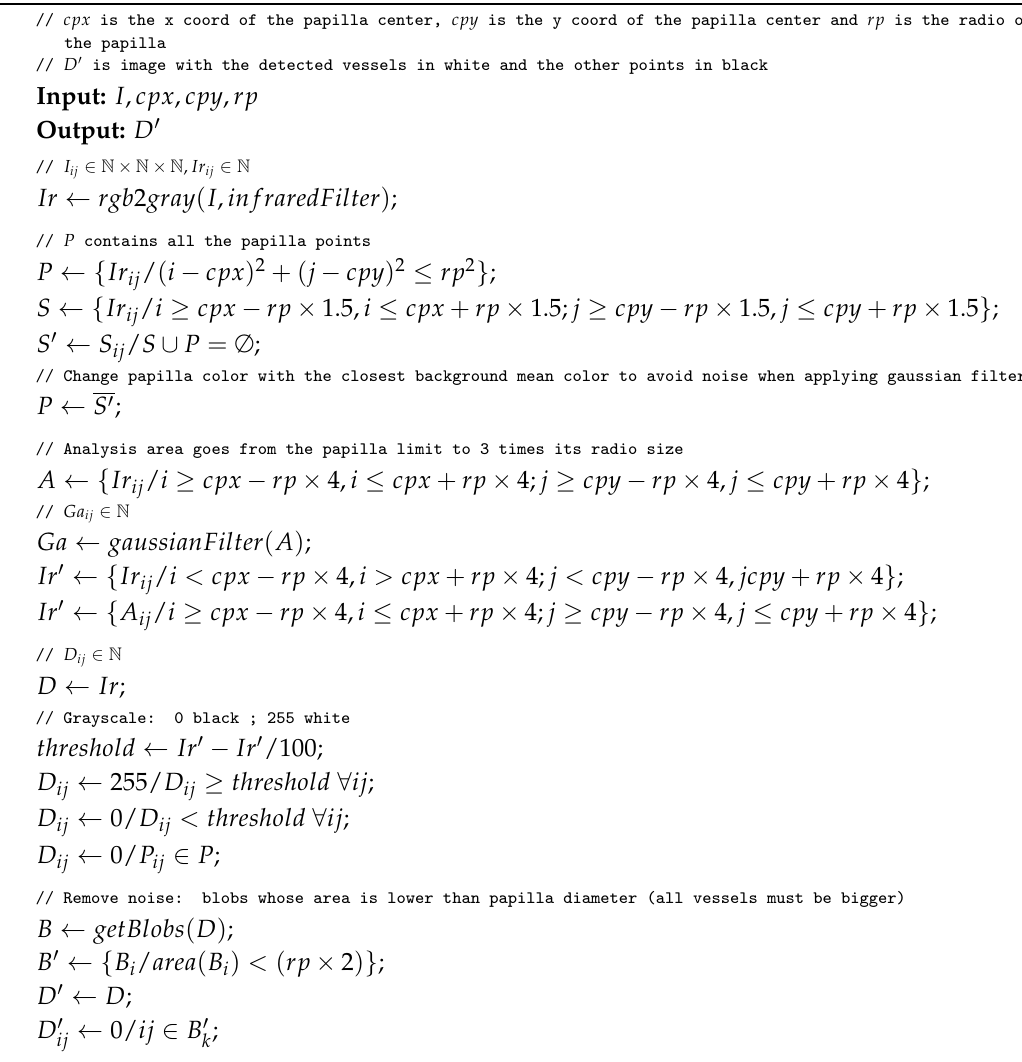
Algorithm 4: Vessels